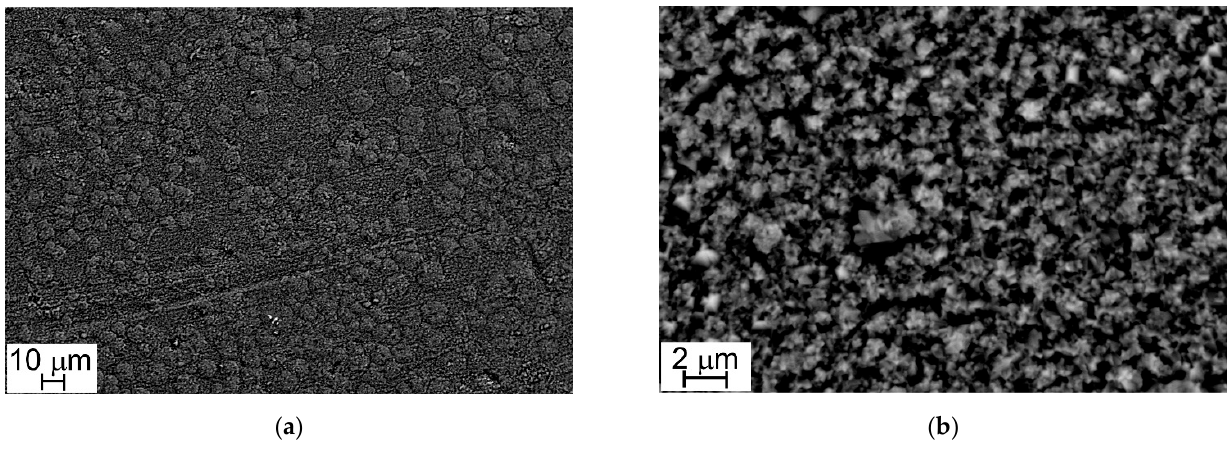
Figure 5. SEM-SE micrograph, Steel B surface (1000×, a ) and (10,000×, b ). At low magnification (1000 × ), sample surfaces show a similar appearance: they are